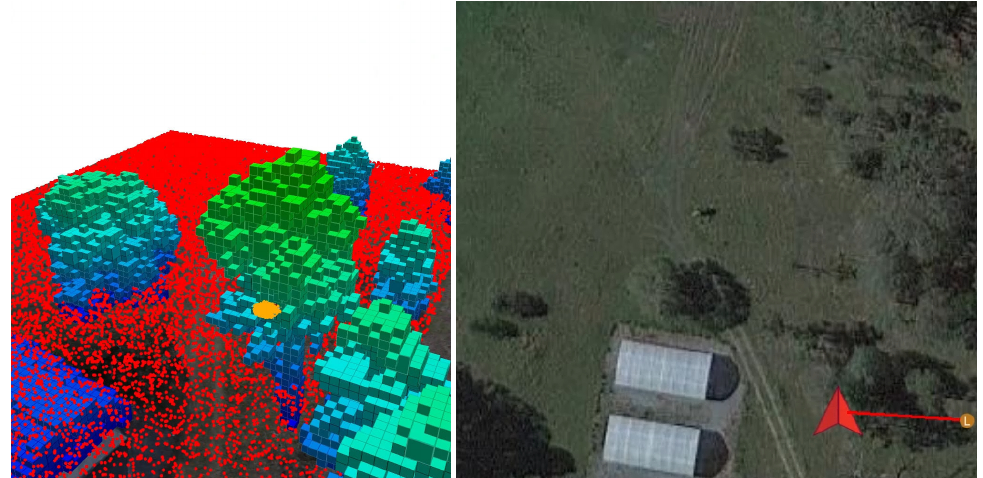
Figure 11. Probabilistic distribution of initial UAV and victim position belief across the survey extent. The UAV position belief (orange points) follows a normal distribution with mean equals to p u 0 and standard deviation of 1.5 m. The victim position belief (red points) follow a uniform distribution, whose limits are equivalent to the survey extent of the flight plan from mission